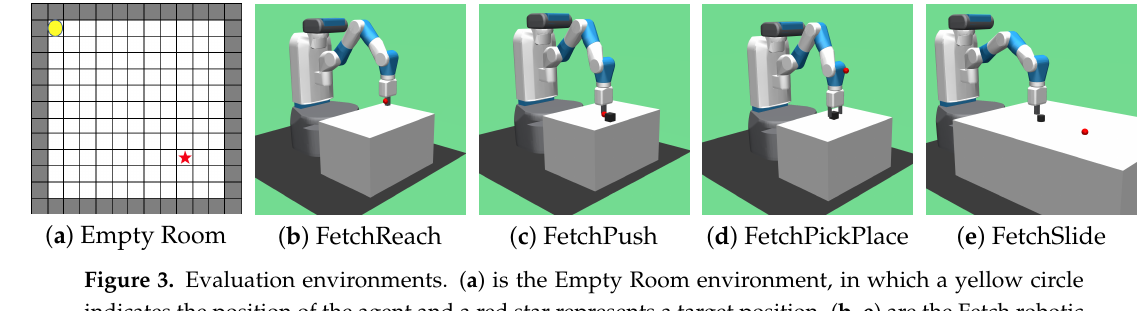
Figure 3. Evaluation environments. ( a ) is the Empty Room environment, in which a yellow circle indicates the position of the agent and a red star represents a target position. ( b – e ) are the Fetch robotic environments. The red spot represents a target